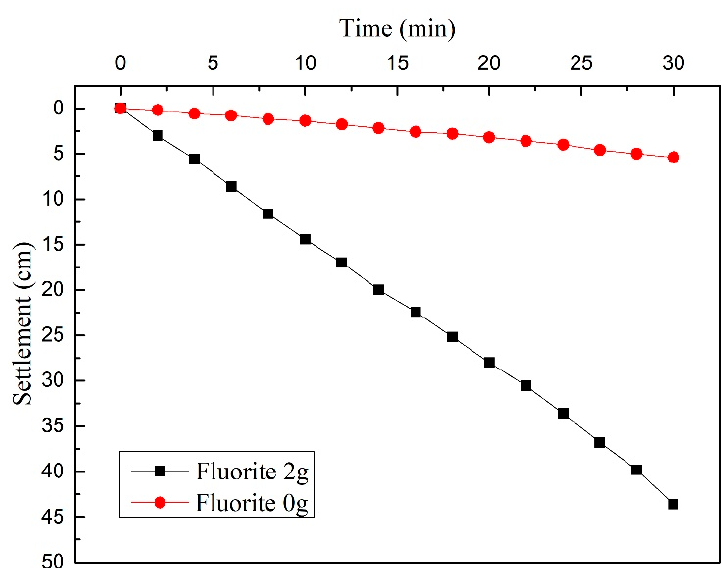
Figure 3. Sedimentation test results when fluorite is added at 0 g and 2 g. (Reaction time: 30 min; dosage of calcite: 2 g/L; dosage of hydrochloric acid: 21.76 g/L; oscillation rate: 160 r/min).